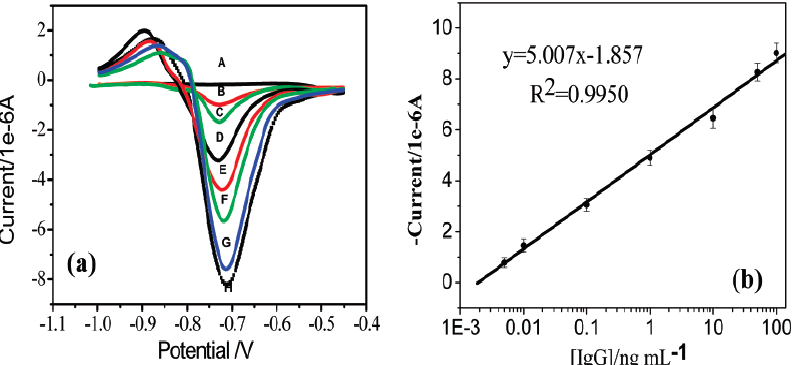
Figure 4. (a) Typical square wave voltammograms of electrochemical immunoassay with increasing HIgG concentration (from A to H: 0, 0.005, 0.01, 0.1, 1.0, 10, 50, and 100 ng mL −1 HIgG, respectively). (b) The resulting calibration curve of HIgG plotted on a semi log scale